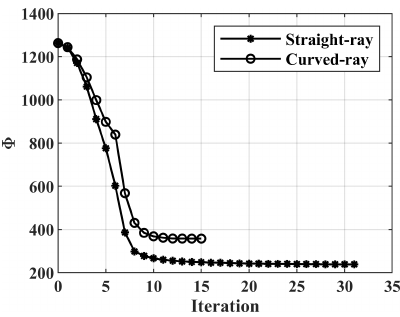
Figure 12. The values of misfit function at different iterations of SWT inversions.